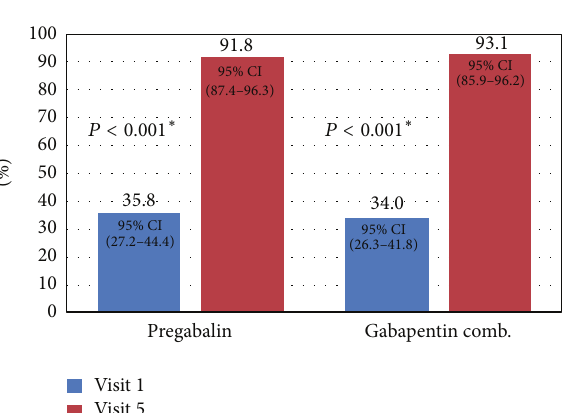
Figure 3: Patients’ Global Impression of Change (PGIC) between baseline and visit 5, specifically the question: “From study start, my health is much improved or very much improved.” Patient Global Impression of Change (IGCP) at visit 1 (baseline) and visit 5 (Day 84). From study start, my health is much improved or very much improved. ∗ Statistically significant change from the baseline by visit in both treatment